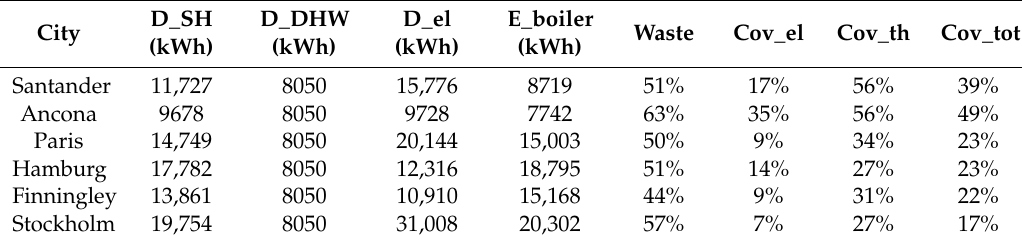
Table 7. Thermal performance of the Innova MicroSolar plant coupled with a terraced house (4